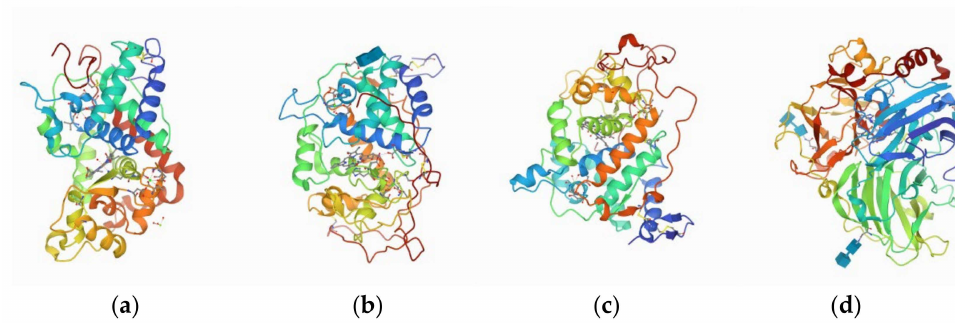
Figure 1. The structures of ( a ) 1PA2; (b ) 1MNP; ( c ) 1B85; and ( d ) 1GYC